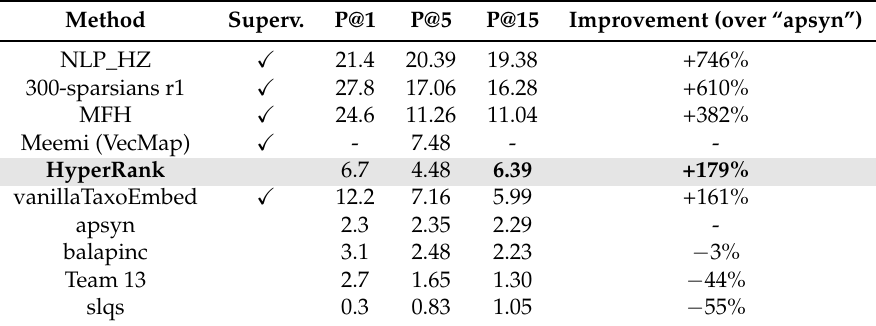
Table 6. Results of evaluation on 1C